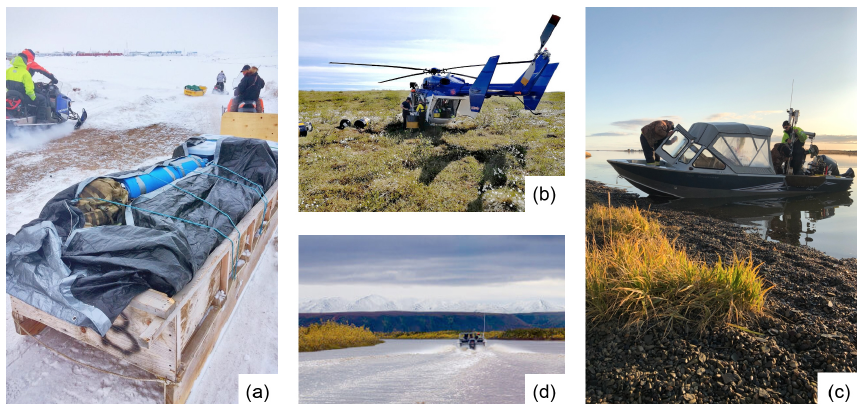
Figure A1. Vehicles used to access sampling regions during the Nunataryuk WP4 field campaign. (a) Snowmobiles during Leg 1 (picture credit: Martine Lizotte). (b) Helicopter during Leg 2 (picture credit: Bennet Juhls). (c) Small boats during Leg 3 (picture credit: Joannie Fer- land). (d) Small boats during Leg 4 (picture credit: Laurent Oziel).